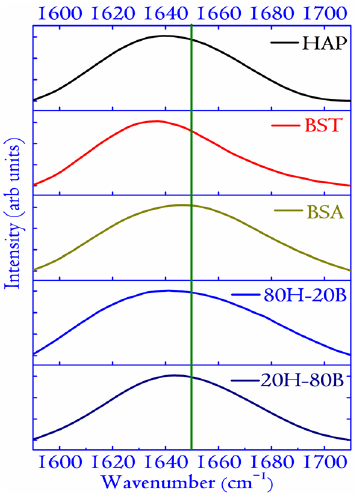
Figure 9. The FTIR spectra of BSA adsorbed surfaces in the Amide-I region (1580–1710 cm − 1 ). The BSA concentration is fixed at 1.000 mg/mL for the adsorption experiments. The vertical line at 1650 cm − 1 determines the shift in the maxima of the peak of BSA on adsorption to various surfaces. The shift is related to the conformational changes in the protein structure upon adsorption onto the surfaces of the compact discs.